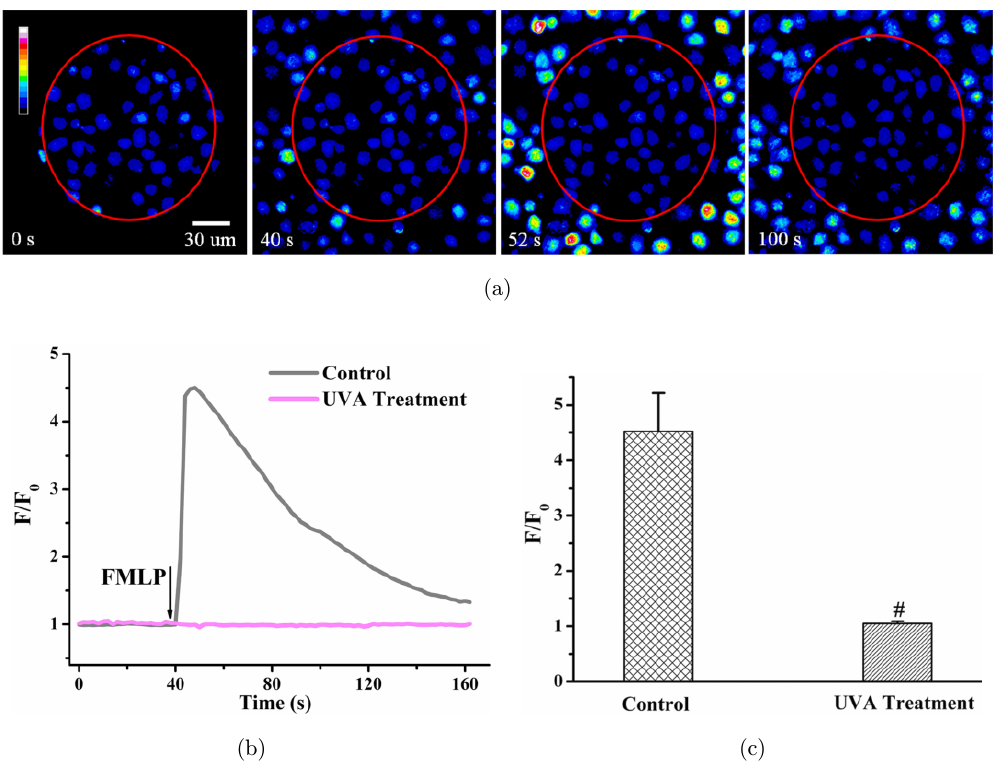
Fig. 2. UVA irradiation blocked FMLP-induced calcium signaling in neutrophils. (a) Typical °uo-3 °uorescent images were shown with false color representations of [Ca 2 þ ] c at 0, 40, 52, and 100 s, respectively. The color range was divided in the spectral sequence from high concentration (white) to low concentration (black). The cells inside the red circle were treated by UVA. (b) Represen- tative tracings of [Ca 2 þ ] c responses in neutrophils to 2 (cid:1) M FMLP activation with or without treatment of 365 nm UVA irradiation. (c) Summary of peak values of F = F 0 were showed as the means (cid:4) SD ( n ¼ 60). p < 0 : 01, compared with control